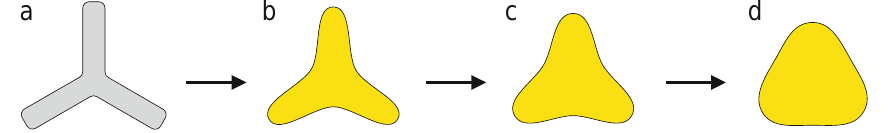
Figure 4. Die swell and fiber drawing. By way of illustration, the polymer melt is represented in yellow.